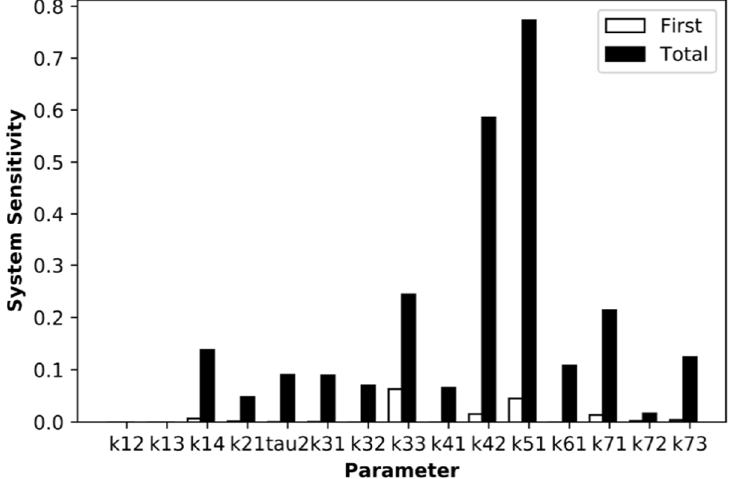
Figure 7. System Sensitivity Analysis carried out on MCMC results. White bars represent First Order Sobol sensitivity indices. Black bars represent Total Order Sobol sensitivity indices. Retinoic acid-inducible gene 1 (RIG-I)’s sole parameter, k 11 , is not shown, as it was not fit via the Monte Carlo method.